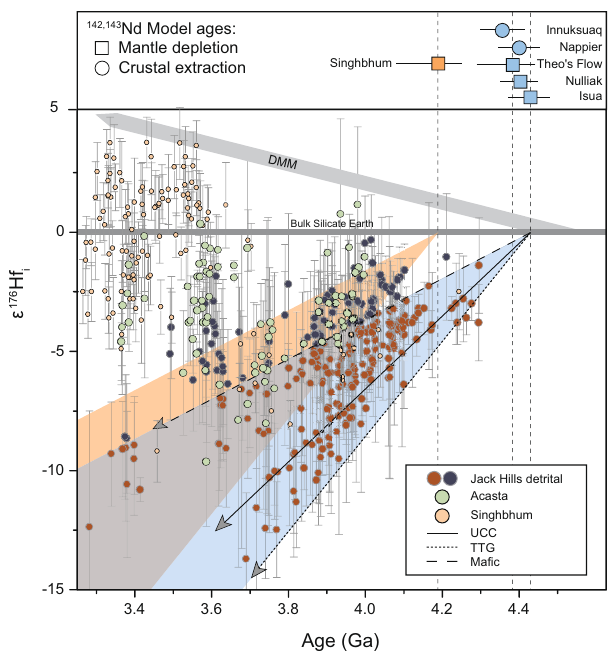
Fig. 3 Comparison of Nd and Hf model ages of mantle depletion and crustal extraction. a Summary of published model ages of crust-mantle differentiation inferred from coupled 146,147 Sm- 142,143 Nd chronometry 32,56 . b Compilation of zircon Hf-isotope compositions and associated 2 SD external reproducibility; detrital zircon data from the Jack Hills metaconglomerate 3,4 (dark red/blue), igneous zircon from the Acasta Gneiss Complex 43,45 (green), and detrital and xenocrystic zircon from the Singhbhum Craton 41,42 (orange). The DMM (depleted MORB mantle) approximates the isotope evolution of Earth ’ s upper mantle from its origin ( ε 176 Hf i = 0 at 4.4 – 4.5 Ga) to the present-day ( ε 176 Hf i ≈ + 15). The coloured arrays (blue and orange) show the expected isotope evolution of juvenile crust extracted from a primitive mantle reservoir (bulk silicate Earth) at 4.42 Ga and 4.19 Ga. The arrays are bound by the isotope trajectories of a ma fi c reservoir with 176 Lu/ 177 Hf of 0.022, a tonalite – trondhjemite – granodiorite (TTG) reservoir with 176 Lu/ 177 Hf of 0.005; a crustal reservoir with 176 Lu/ 177 Hf of 0.008, corresponding to the average upper continental crust (UCC), is shown for comparison 3,4 . Dark red data points show zircon grains with initial ε 176 Hf consistent with differentiation of their protoliths during an early crust formation event at ~4.4 Ga. Dark blue circles represent zircon grains with initial ε 176 Hf requiring a younger crustal protolith, consistent with zircon data on Acasta and domains. Some of these depleted domains were produced during or shortly after the end of terrestrial accretion, possibly as a result of magma ocean crystallisation, while others, like the Singhbhum source region, may re fl ect crust extraction in the late Hadean.